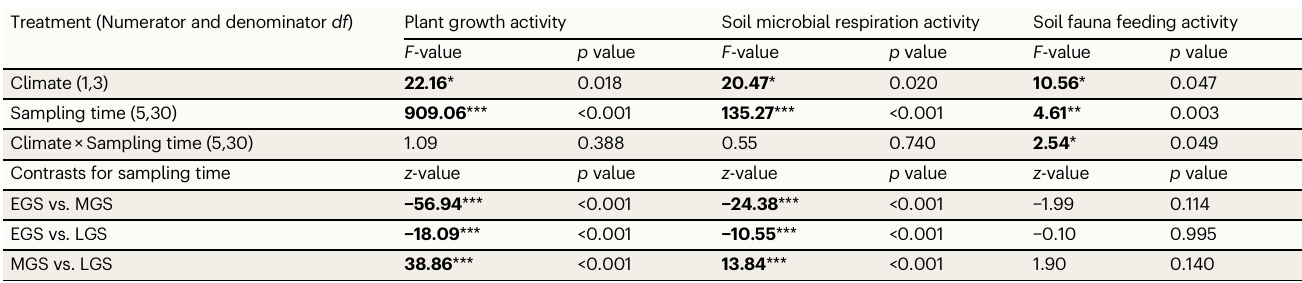
Table 1 | Results ( F -values) of linear mixed effects models (Type III ANOVA with Kenward – Roger ’ s method) testing the effects of climate (ambient vs. experimental warming), sampling time (i.e., 6 months of the growing season), and their interaction on plant growth activity, soil microbial respiration activity, and soil fauna feeding activity (all log-scaled) Treatment (Numerator and denominator df ) Plant growth activity Soil microbial respiration